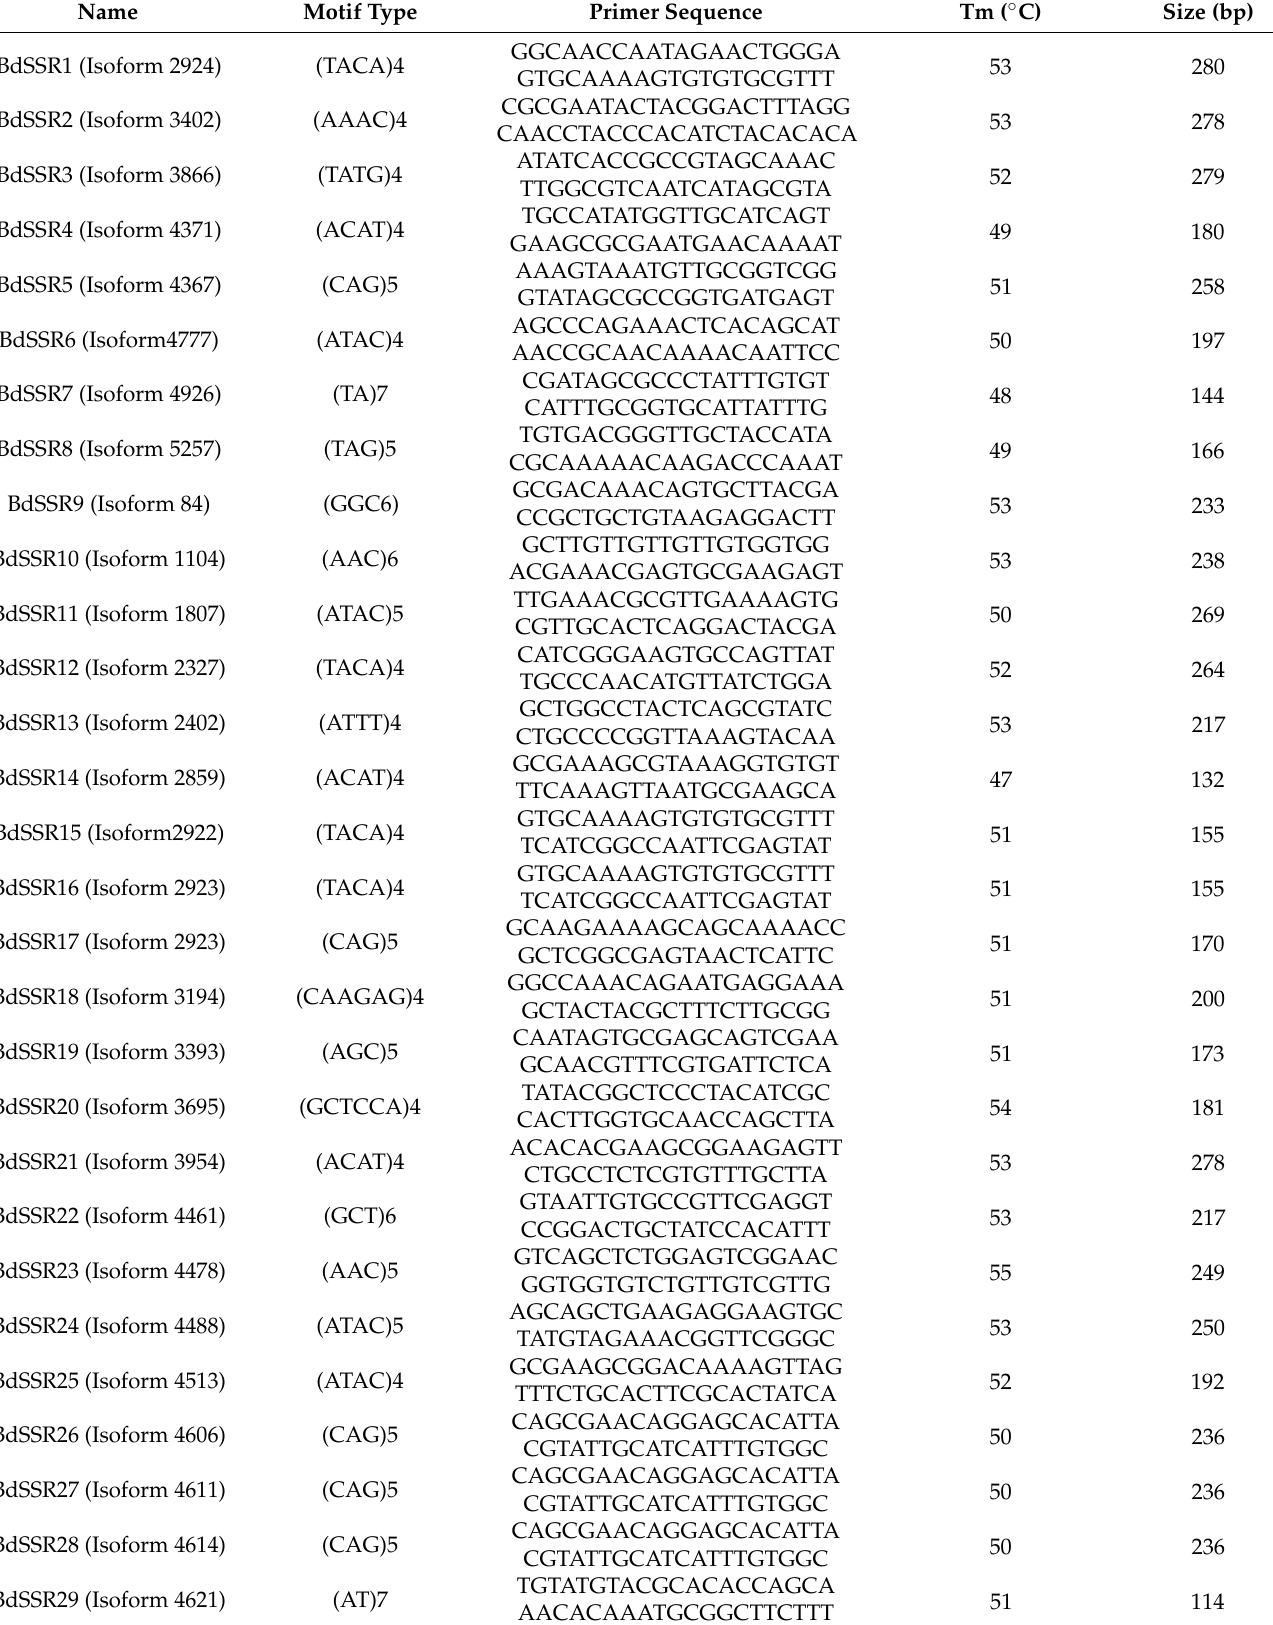
Table 6. Primer sequences for microsatellite markers and optimal PCR